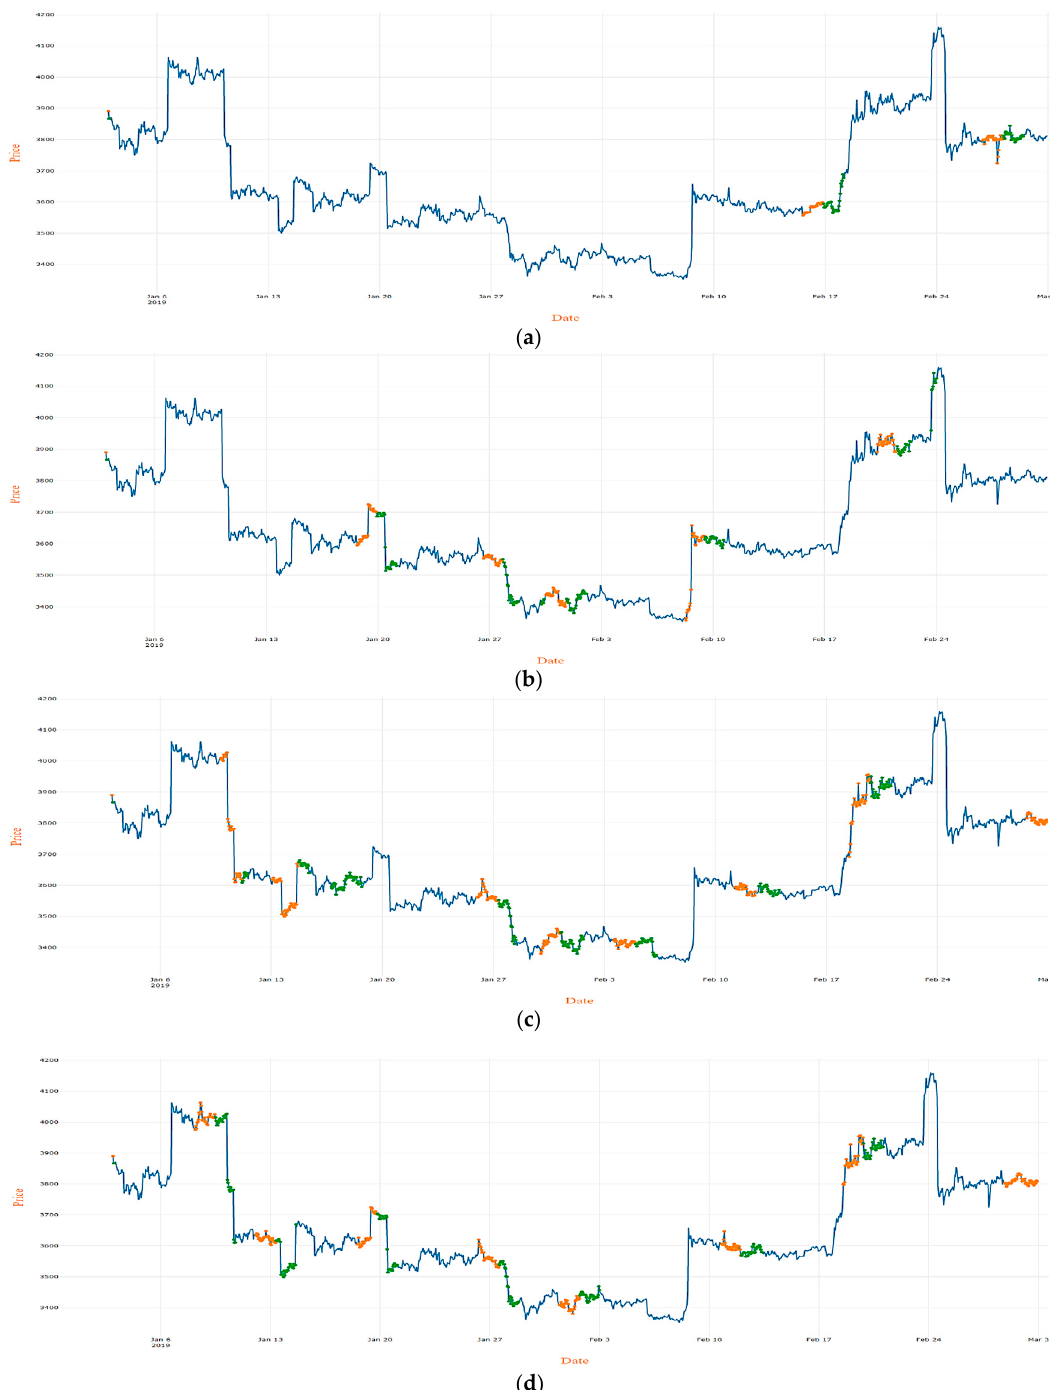
Figure 7. Plotting results after testing with different training time. Buy actions set with green and sell actions with yellow: ( a ) 70th training time; ( b ) 80th training time; ( c ) 90th training time; ( d ) 100th training time.